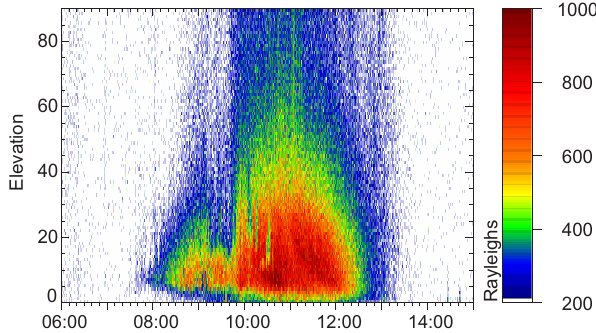
Fig. 3. The time evolution in UT of the 428nm background con- tinuum data from the Longyearbyen Auroral Station MSP on 6 De- cember 2002. The signal is integrated over a 5 ˚A filter. The MSP scans elevation at a fixed azimuth, 135 ◦ from North.